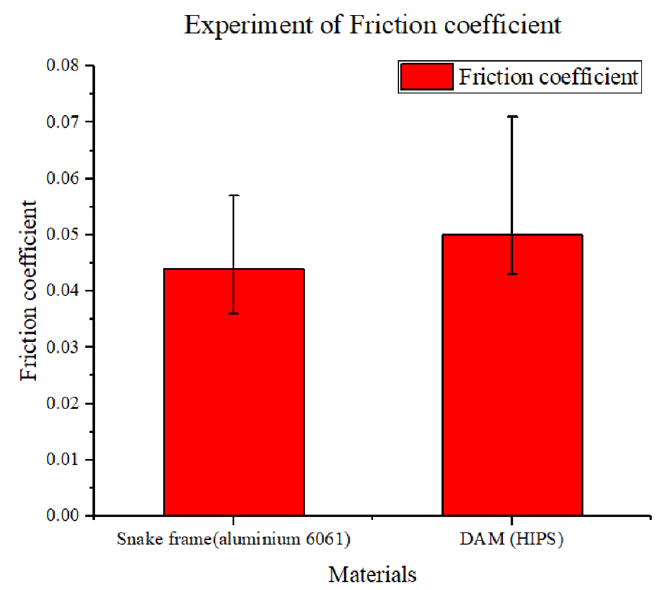
Figure 17. Friction coefficient result.